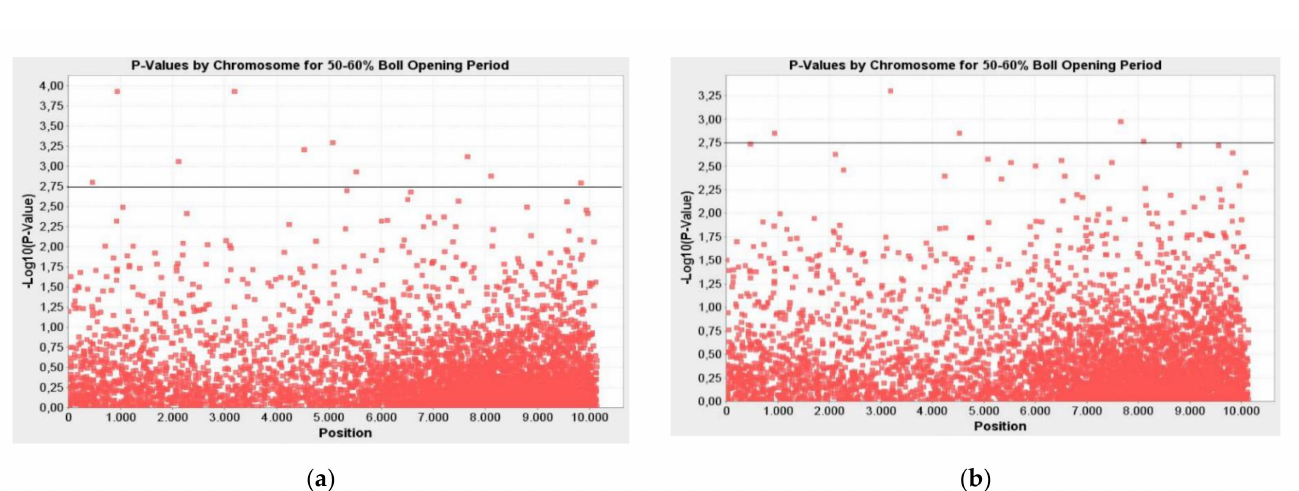
Figure 1. Manhattan plots for markers associated with resistance/tolerance to Verticillium wilt Disease Severity Index (DSI) on leaves at the 50–60% boll opening period; ( a ) general linear model (GLM); ( b ) mixed linear model (MLM); the line indicates the significance threshold (-LOG10 ( p -Value) <